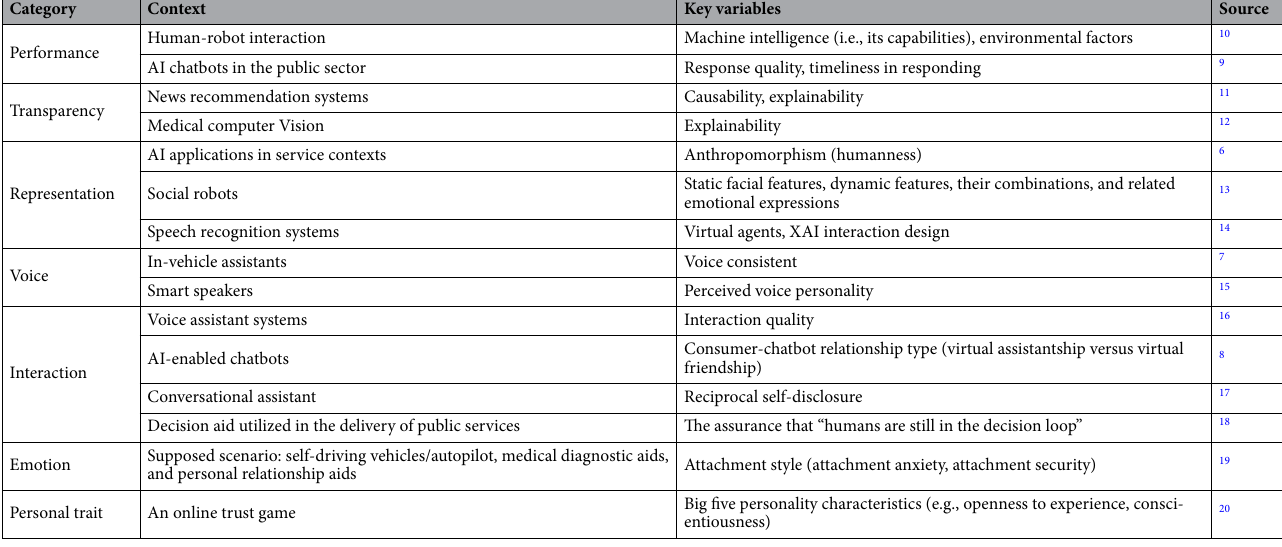
Table 1. Studies on the antecedents of trust in